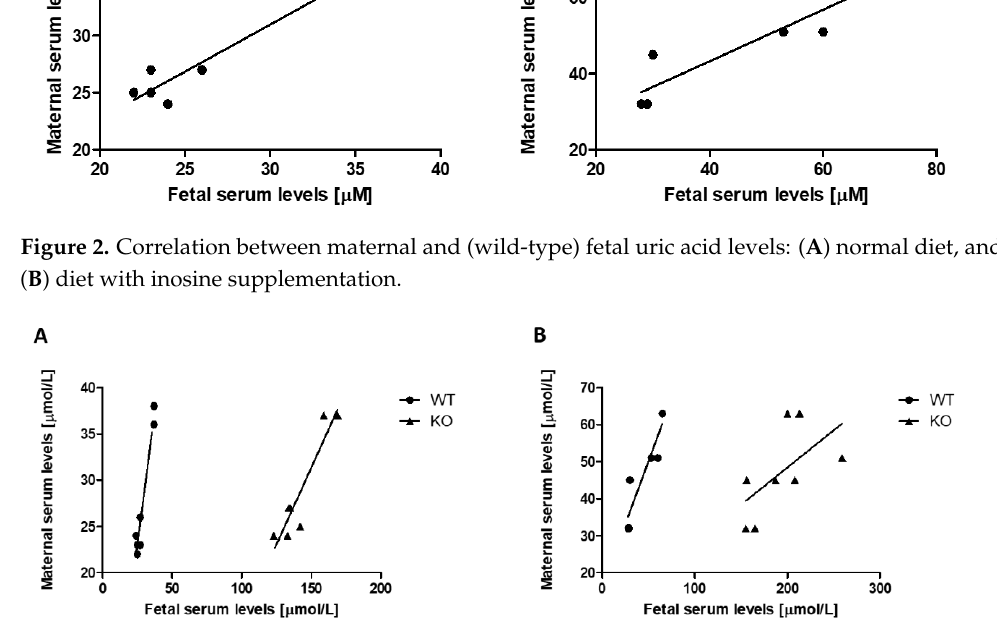
Figure 3. Correlation between maternal and (G9KO) fetal uric acid levels: ( A ) normal diet, and ( B ) diet with inosine supplementation.